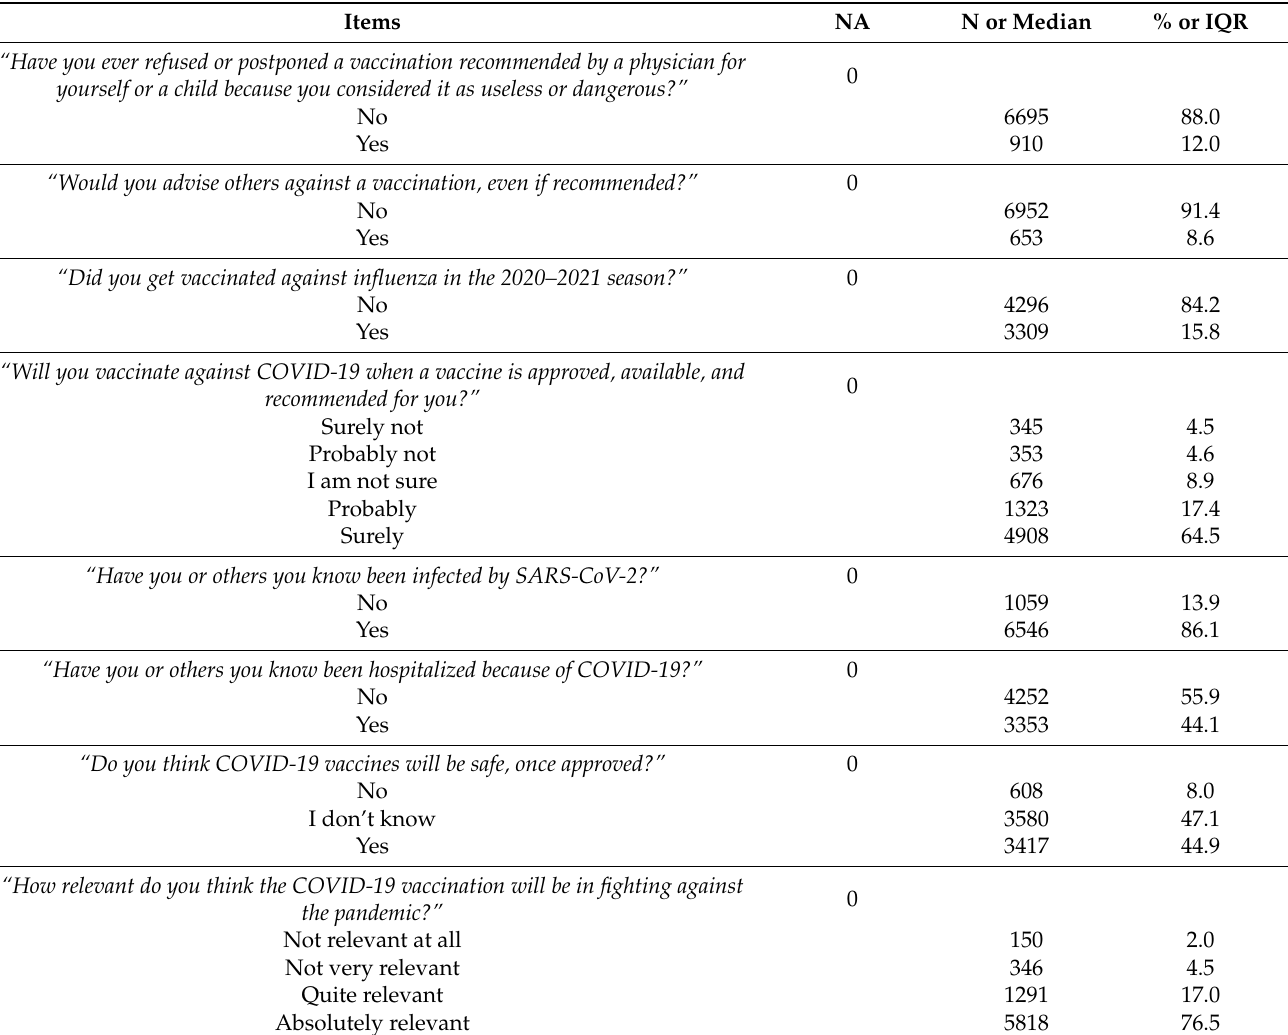
Table 2. Personal beliefs about vaccinations and the willingness to vaccinate against COVID-19. Items NA N or Median % or